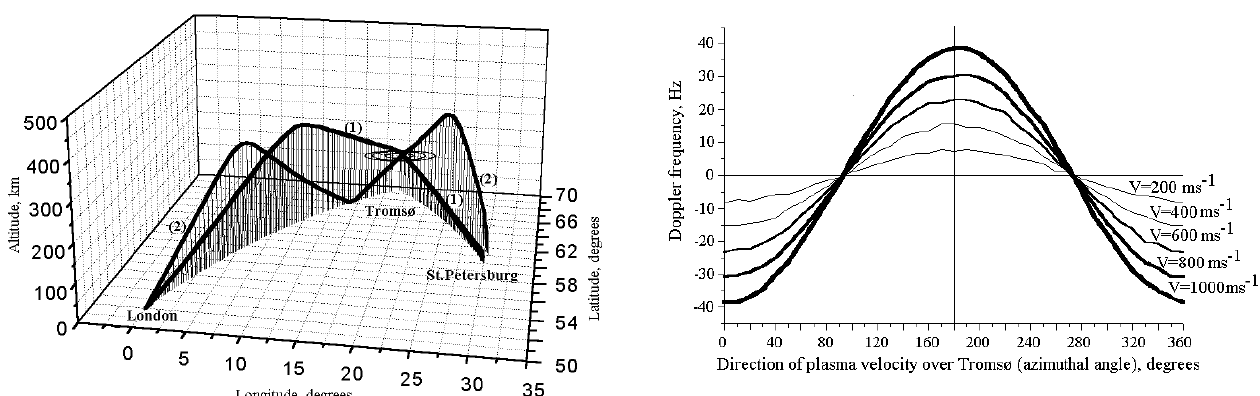
20.4 ◦ E), Lerwick (60.1 ◦ N; 2 ◦ W), and St. Petersburg (60 ◦ N; 30.5 ◦ E).